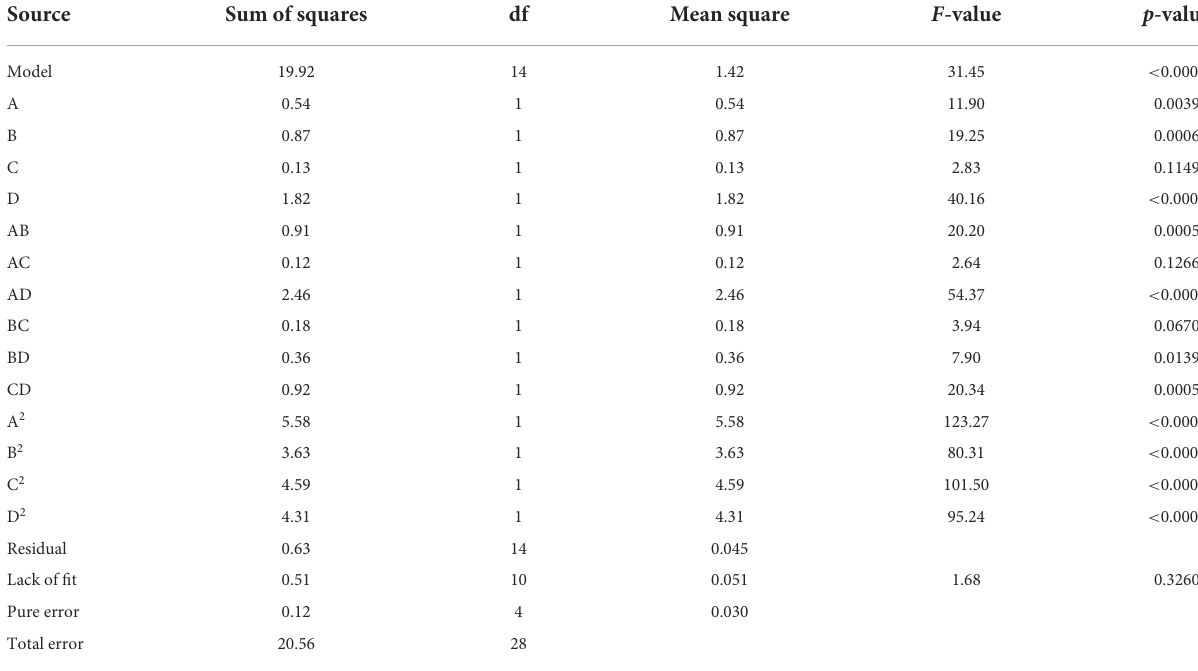
TABLE 3 The results of the ANOVA for the regression equation fitted the response content. Source Sum of squares df Mean square F -value p -value